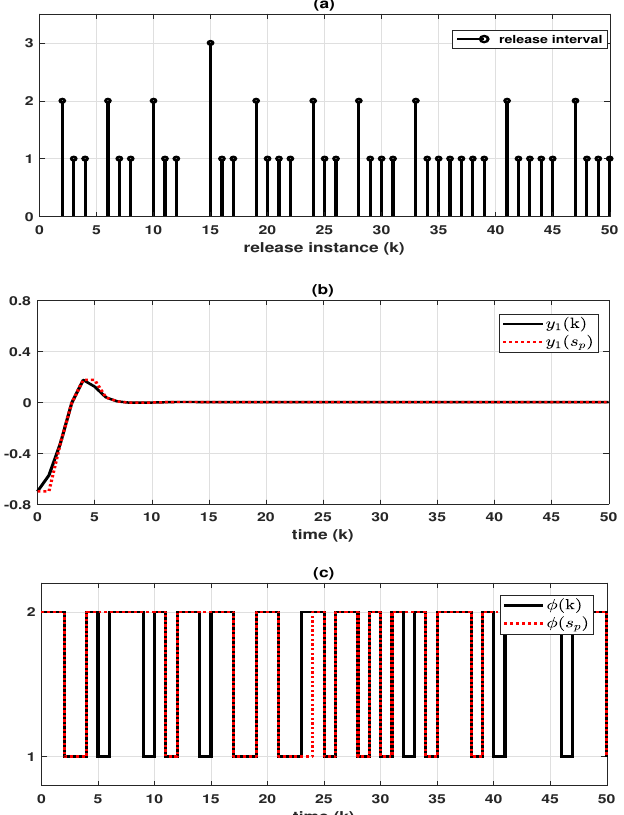
Figure 2. Event-triggered transmission: ( a ) the release instance and interval, ( b ) measured output y ( k ) and y ( s p ) , and ( c ) evolution of φ ( k ) and φ ( s p ) .